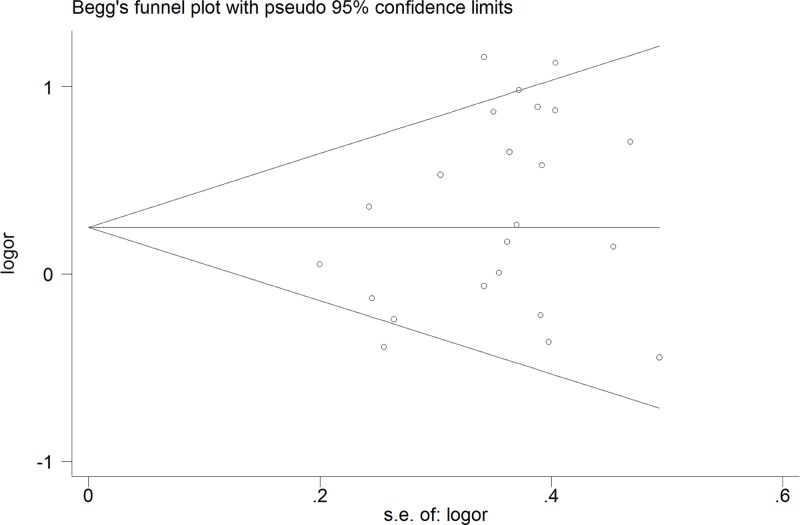
Begg’s funnel plot for contrast in a recessive model (AA vs. TT+TA).Each point represents a separate study for the indicated association. Size graph symbol by weights. LogOR natural logarithm of OR. Horizontal line mean effect size.